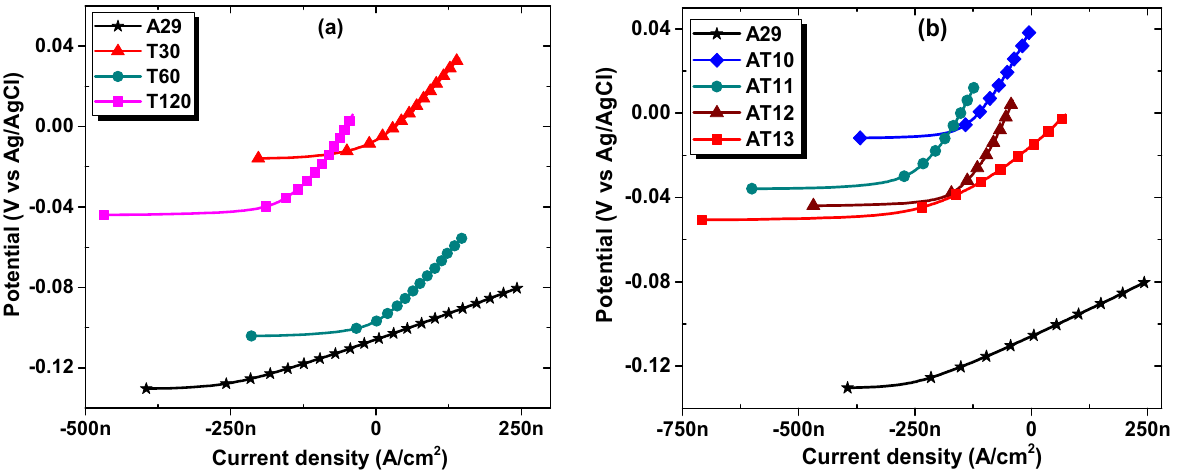
Figure 8. LPR curves showing the effect of ( a ) solutionizing duration and ( b ) solutionizing temperature on the corrosion behavior of UN08029 after 1 hr immersion in 3.5% NaCl aerated solution. Table 3. LPR parameters for the samples solutionized for different durations. Sample ID